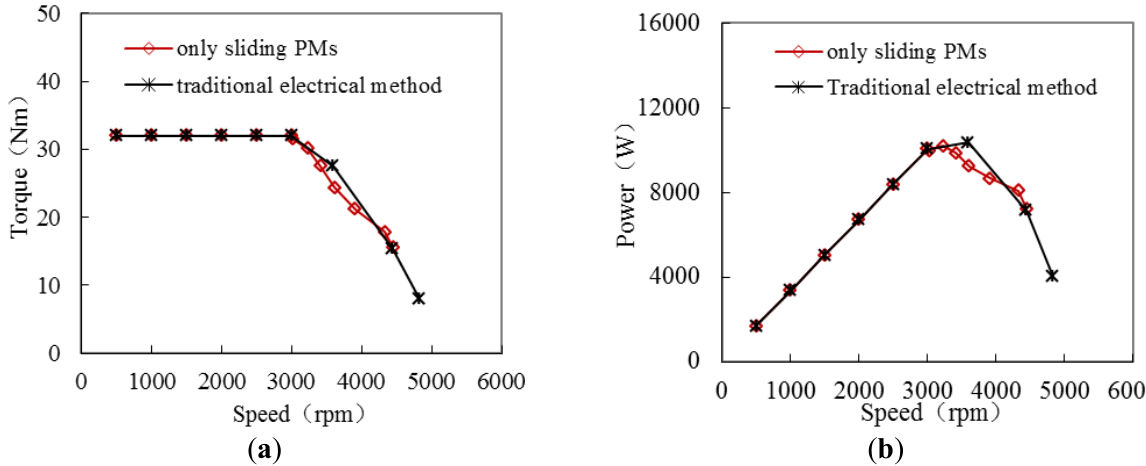
Figure 17. Comparison of the field weakening results by mechanical and electrical methods: ( a ) torque-speed and ( b ) power-speed.